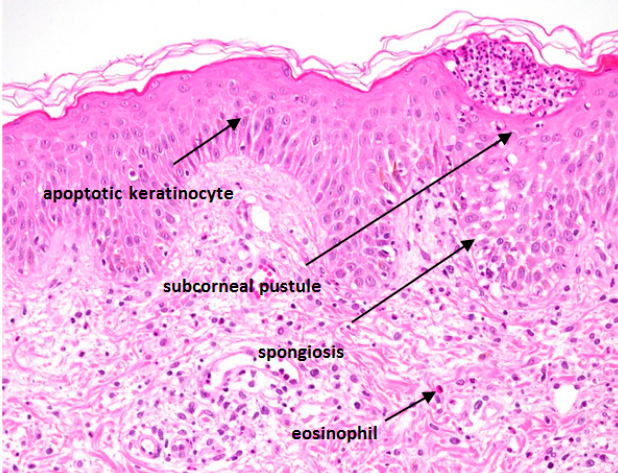
Figure 3. Typical histological features of AGEP are indicated.